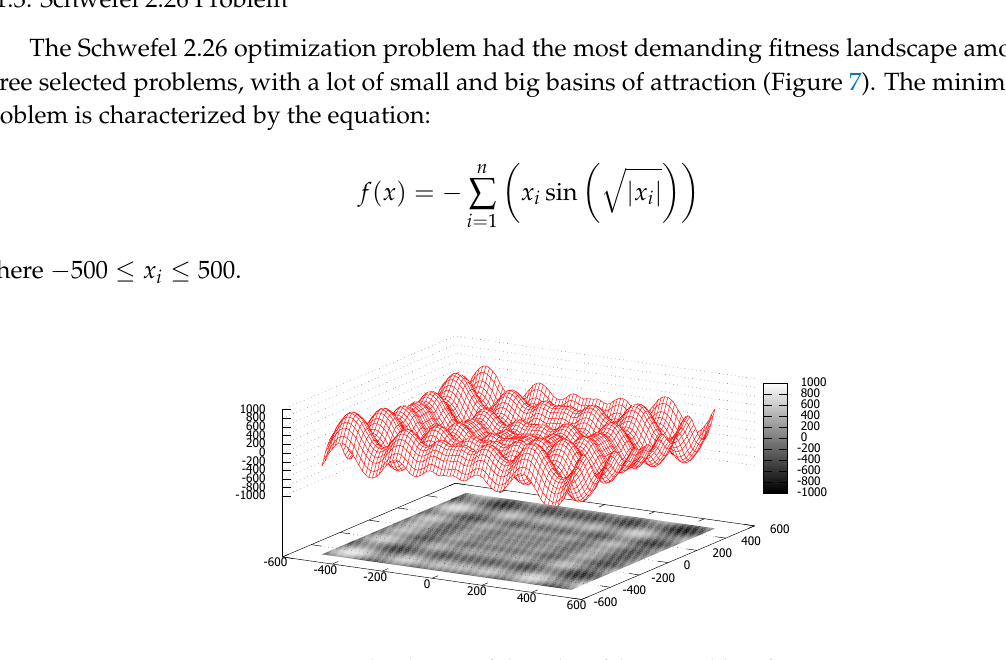
Figure 7. Fitness landscape of the Schwefel 2.26 problem for n =